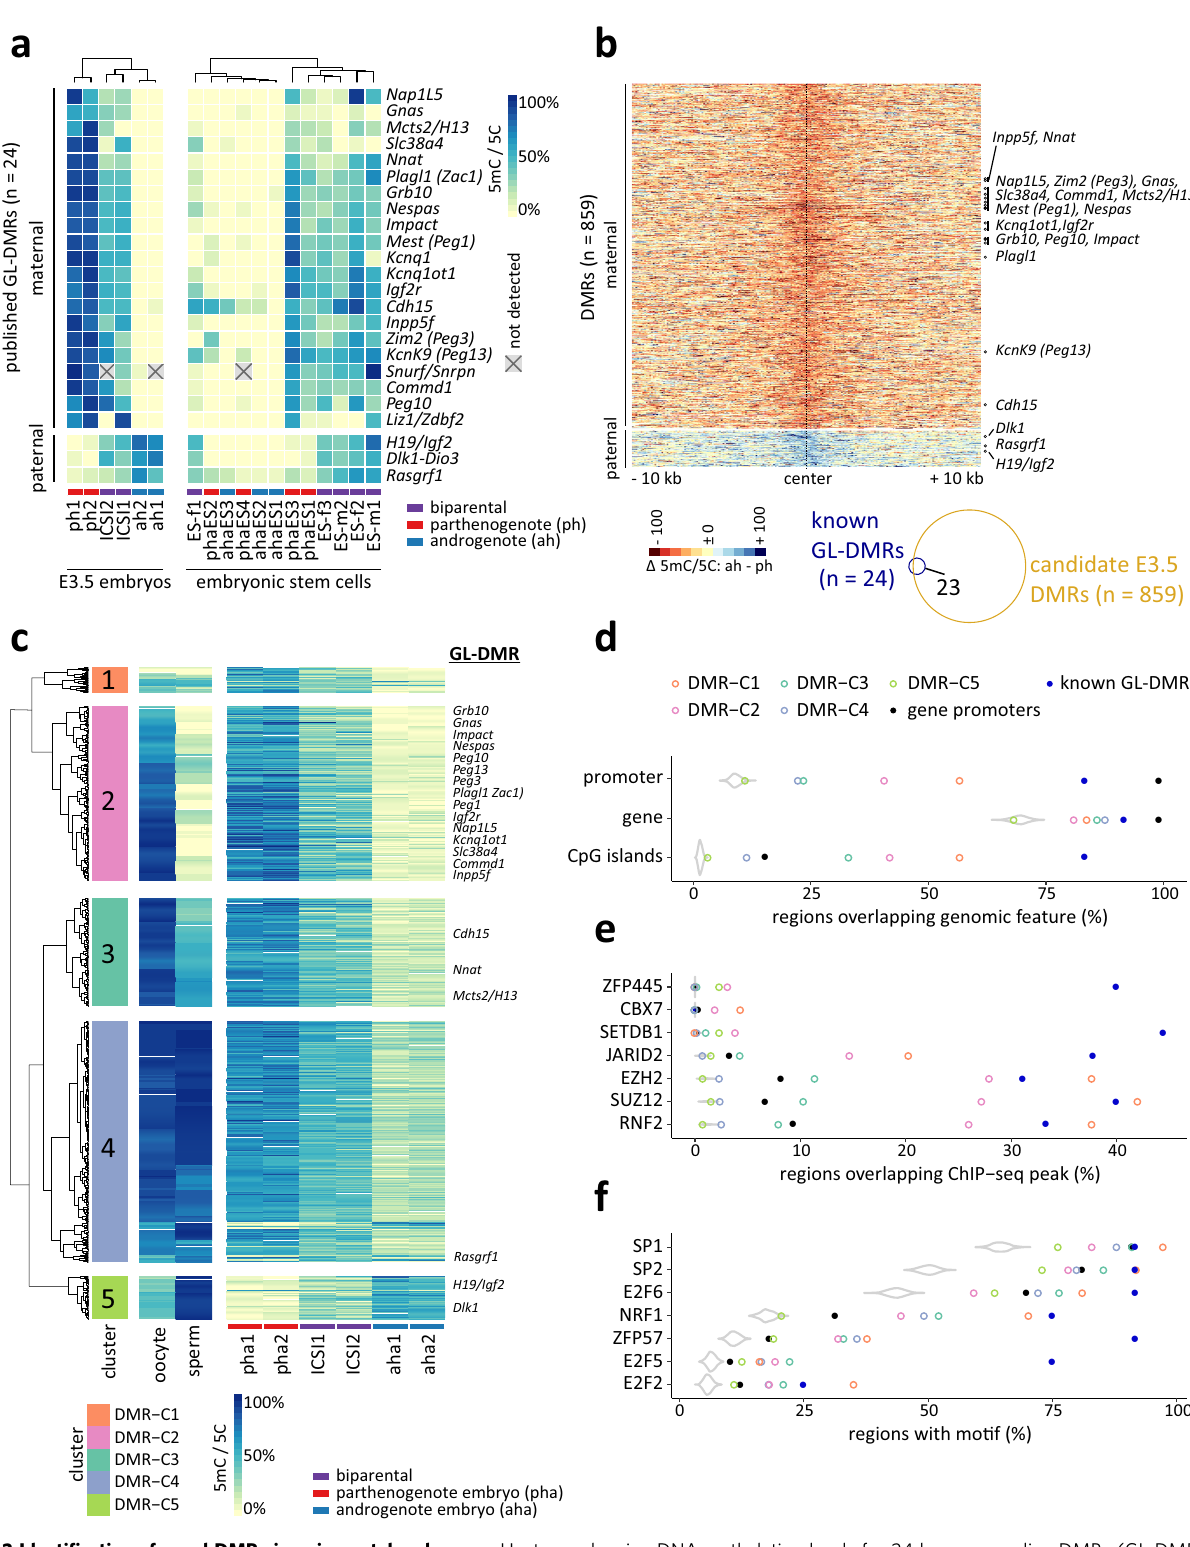
Fig. 2 Identi fi cation of novel DMRs in uniparental embryos. a Heatmap showing DNA methylation levels for 24 known germline DMRs (GL-DMRs) in blastocyst samples (left) and ESCs. Colour scale represents percentage of 5mC compared to 5C. b Heatmap showing DNA methylation signal in a 10 kb window around the centre of all 859 blastocyst DMRs identi fi ed in this work (red, maternal DNA methylation; blue, paternal DNA methylation). Known GL- DMRs are indicated rightmost. c Heatmap showing DNA methylation levels in all 859 blastocyst DMRs in our blastocyst samples compared to oocyte and sperm DNA methylation from published data 26 . Hierarchical clustering was based on DNA methylation levels in gametes. d Distribution of blastocyst DMRs and known GL-DMRs over different genomic features. Gene promoters and 1,000 random sets of regions of comparable size and distribution (from all regions assessed in our DNA methylation analysis, grey) are shown for reference. e Locus overlap analysis 32 of published ChIP-seq peaks for blastocyst DMRs and known GL-DMRs. f Motif enrichment analysis 37,68 for blastocyst DMRs and known GL-DMRs. Source data are provided as Source Data fi